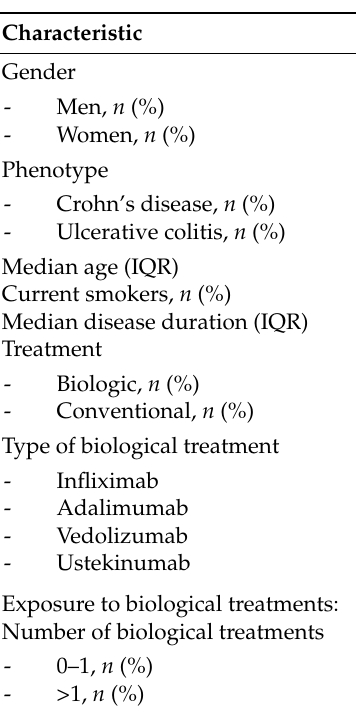
Table 1. Characteristics of study